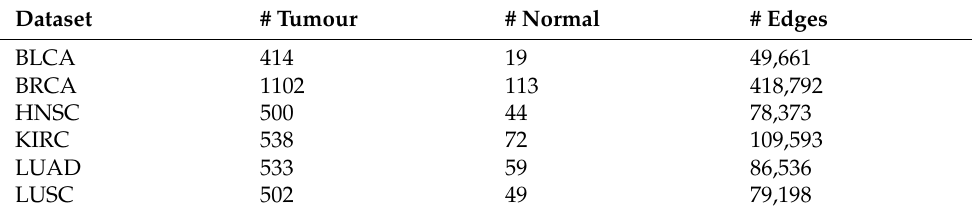
Table 2. Statistics of datasets. # Tumour and # Normal indicate the number of samples labelled tumour and normal, respectively. # Edges indicates the number of connections (edges) in the graph that was constructed according to vector distance (see Section